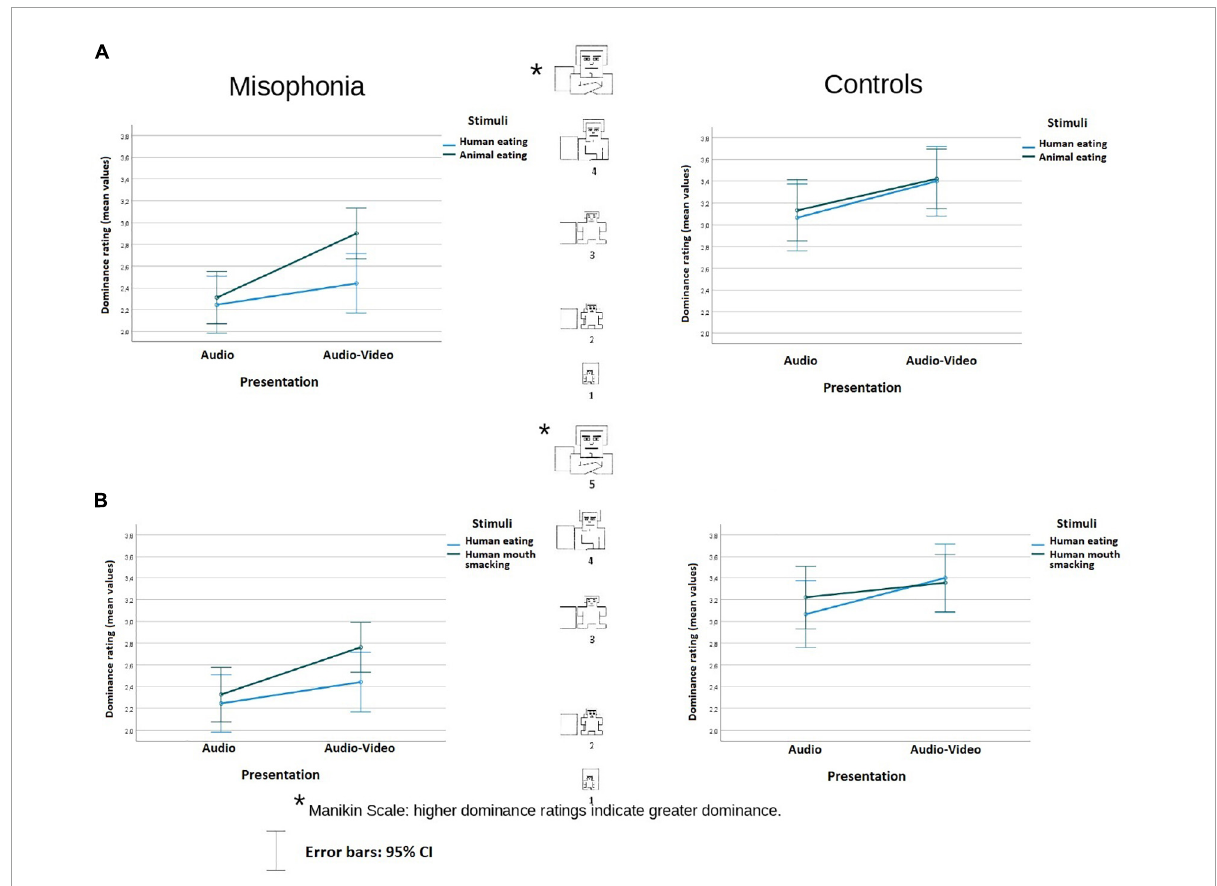
FIGURE3 Dominance rating (mean values) of the stimuli in audio and audio-video conditions in misophonia and the control group, separately for the analysis (A) and the analysis (B) . Higher dominance ratings indicate greater dominance. The distances between the scale values were identical (it is a linear